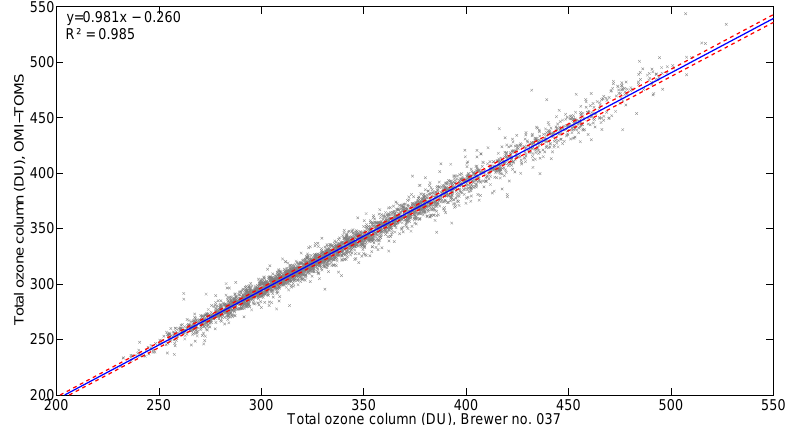
Figure 6. Comparison of Brewer no. 037 direct sun measurements and OMI satellite data using TOMS retrieval algorithm. The Brewer reference value was the closest direct sun measurement with a maximum limit of 1h difference in the measurement